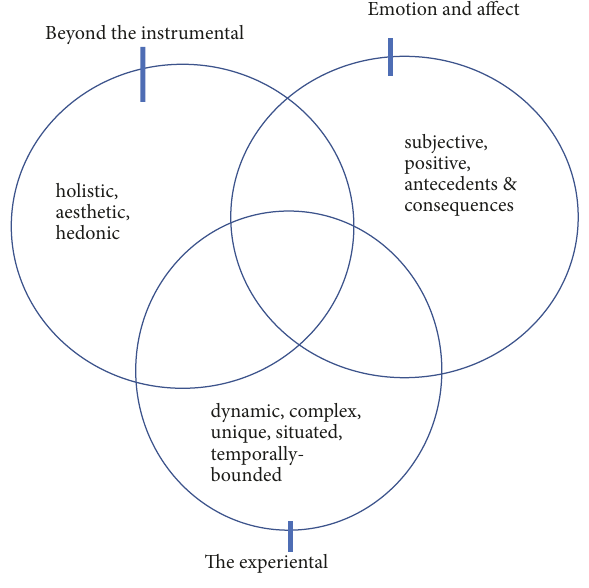
Figure 1: Facets of UX ([28], p